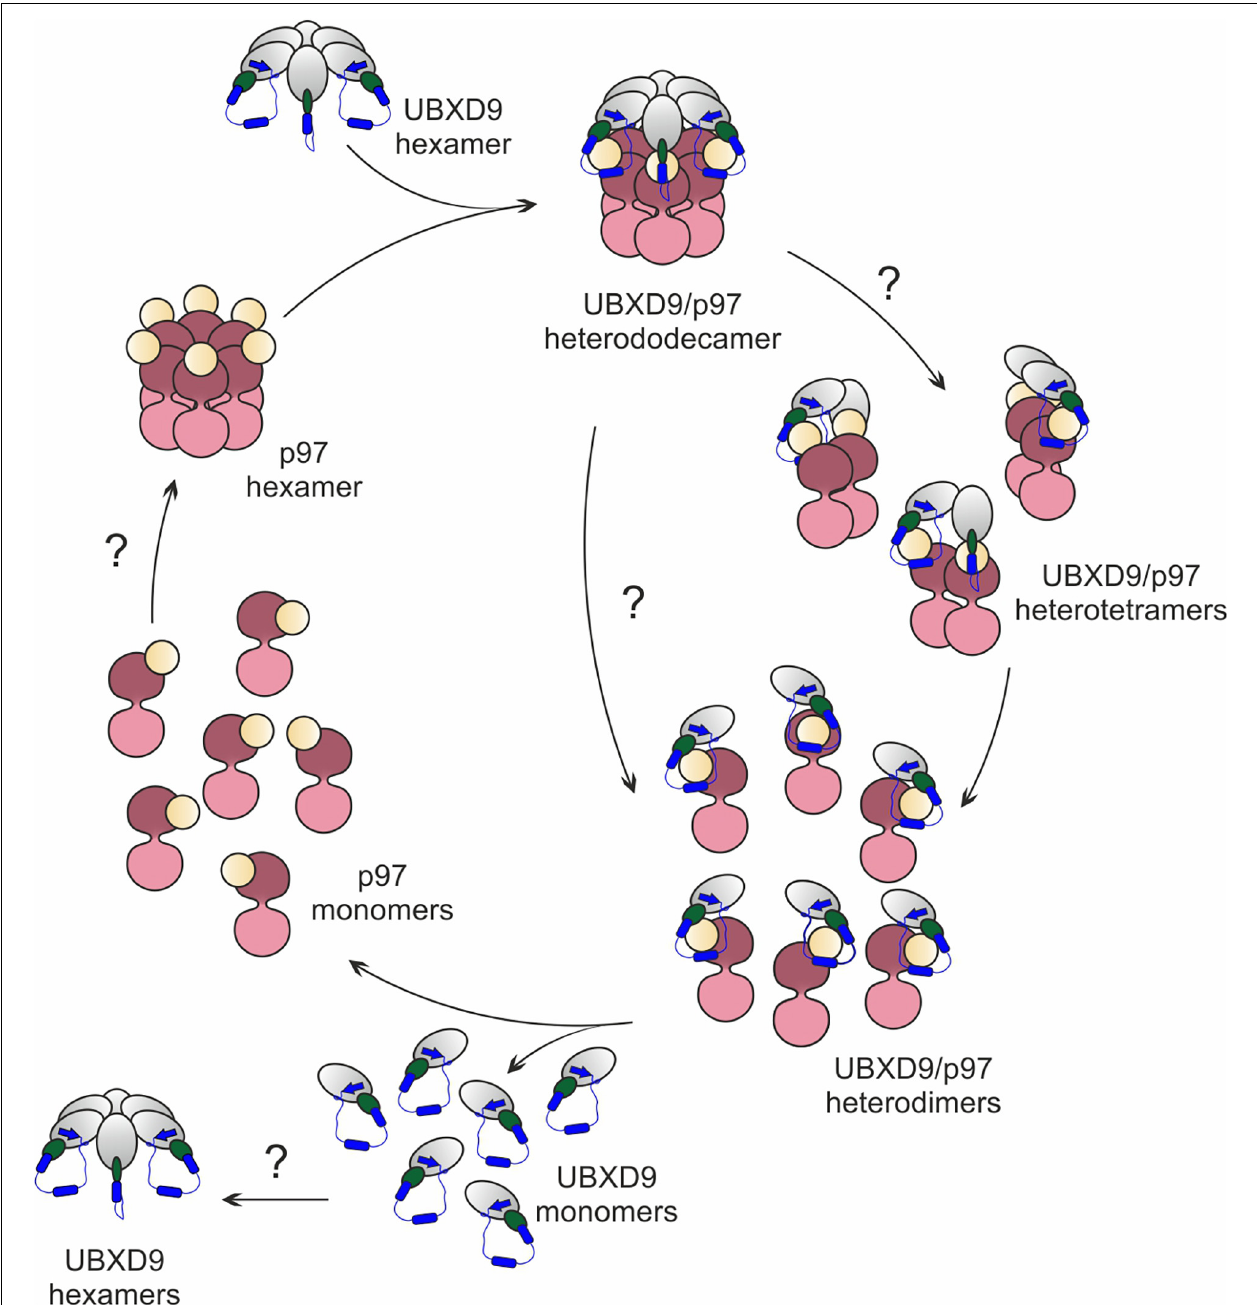
FIGURE 8 | Structure-based model for the disassembly of the p97 hexamer by UBXD9. We propose, that a D. discoideum UBXD9 hexamer binds to a p97 hexamer and forms in the first step a hetero-dodecamer. The course of the dissociation of this complex is still unclear and possibly proceeds via intermediate steps. This could result in hetero-tetramers, which then dissociate to heterodimers and finally UBXD9 and p97 monomers are released. These are then free for another round of oligomerization. The p97 D1 and D2 domains are depicted in dark and light pink, respectively, and the N domain in yellow. UBXD9 is shown schematically with the UBX domain in green. The blue cylinders represent the α 0 and α - 1 helices and the blue arrow the β 0 strand.